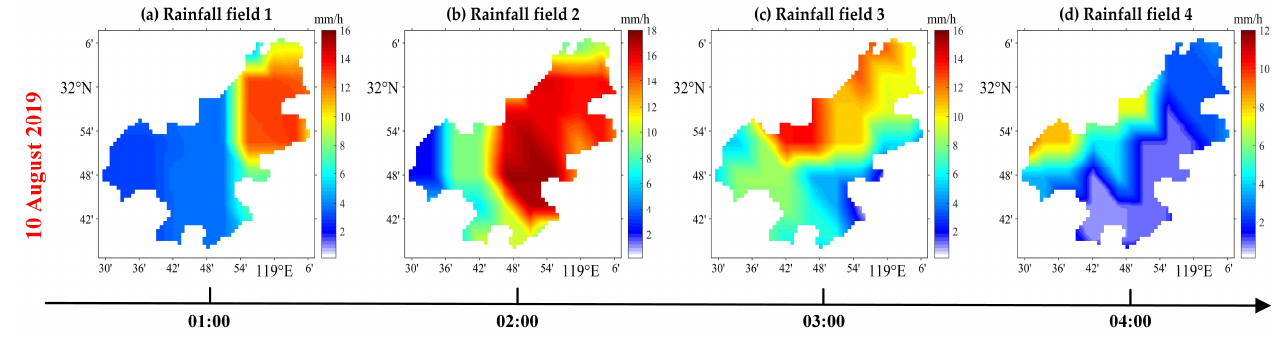
Figure 4. Rainfall fields for the rainfall event with intervals of 1 h during 01:00~04:00 on 10 August 2019 in Jiangning district, Nanjing. ( a ) is the rainfall field 1 at 01:00, ( b ) is the rainfall field 2 at 02:00, ( c ) is the rainfall field 3 at 03:00, and ( d ) is the rainfall field 4 at 04:00.